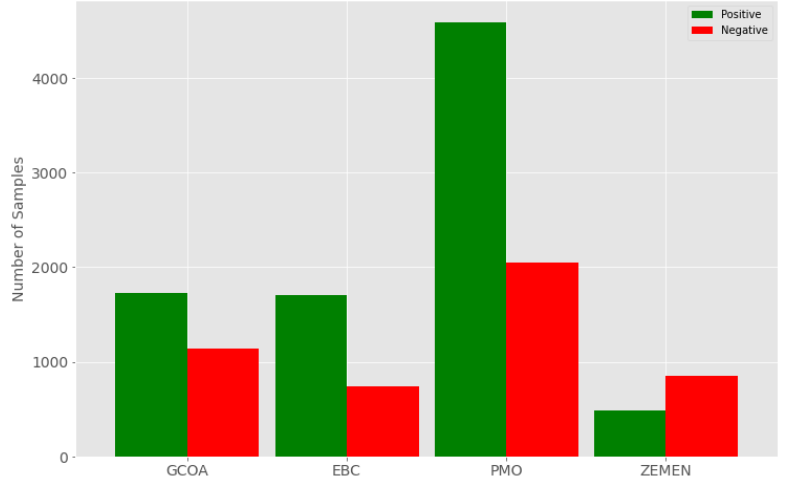
Figure 3. The Labeled Sentiment Corpora’s Class